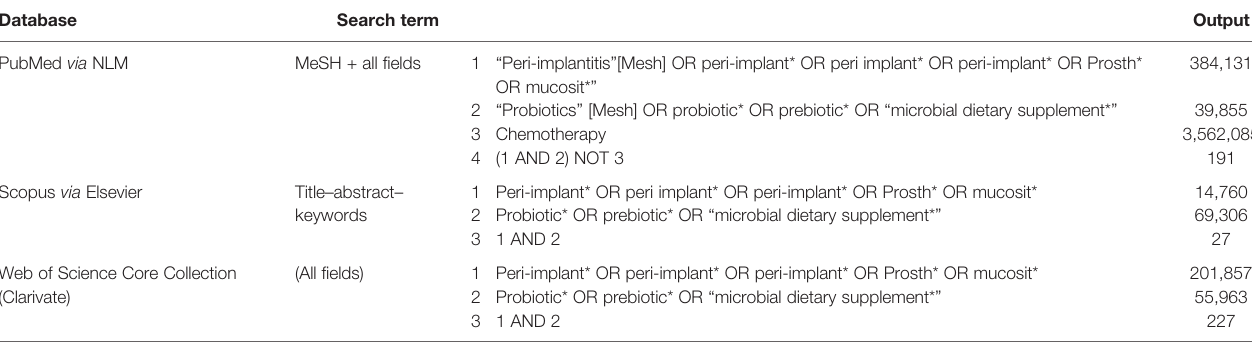
TABLE 1 | Search terms and output in the three MEDLINE databases via PubMed, Scopus, and Web of Science Core Collection.